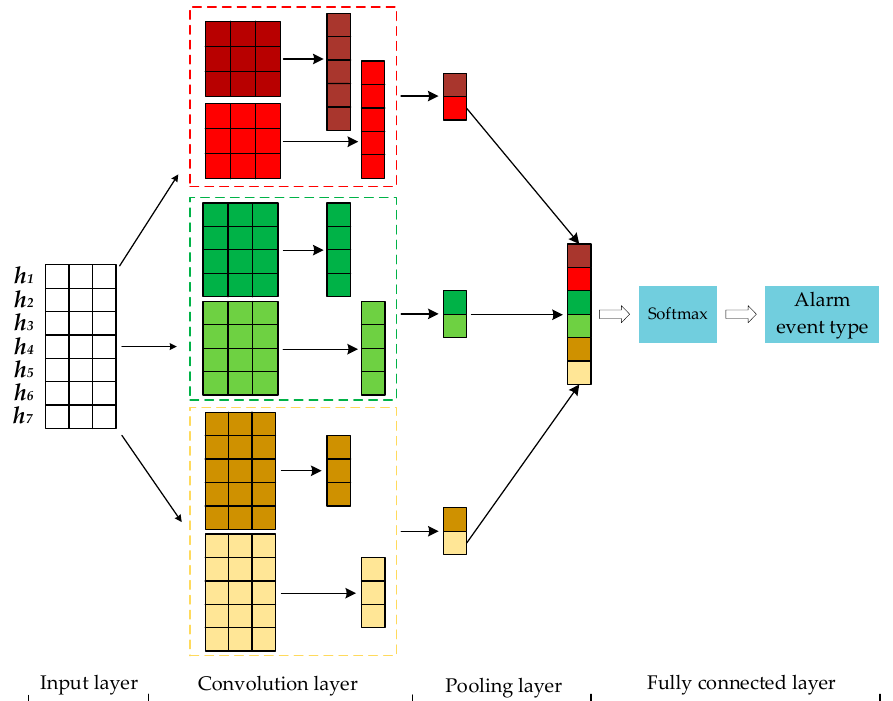
Figure 7. Structure of convolutional neural network (CNN).